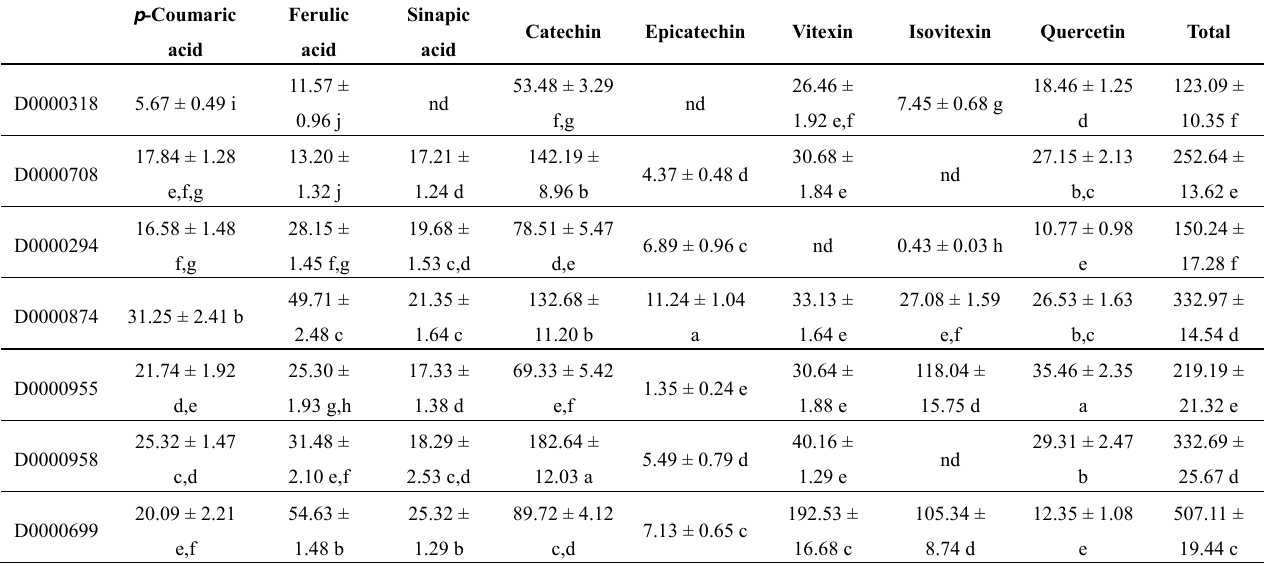
Table 1. Content of individual phenolic compounds in rice beans (in μ